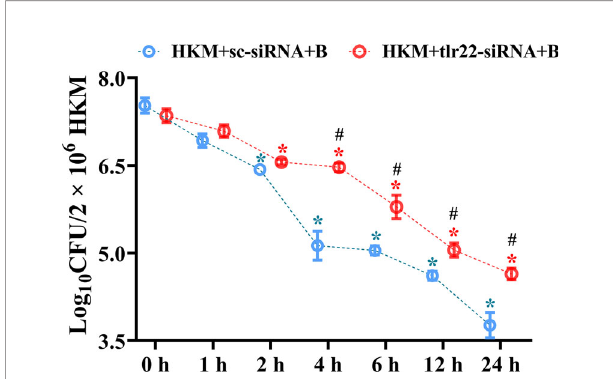
FIGURE 1 | TLR22 signaling restrain A. hydrophila replication in HKM. HKM were transfected with sc-siRNA or tlr22 -siRNA, infected with A. hydrophila and bacterial load was enumerated at indicated time points. Data represent mean ± SEM (n=3). Asterisk (*) signi fi es signi fi cant difference as compared to 0 h (* p < 0.05), Hashtag (#) signi fi es signi fi cant difference between the group ( # p < 0.05). HKM+sc-siRNA+B, HKM+tlr22-siRNA+B, sc-siRNA and tlr22-siRNA transfected HKM were infected with A. hydrophila